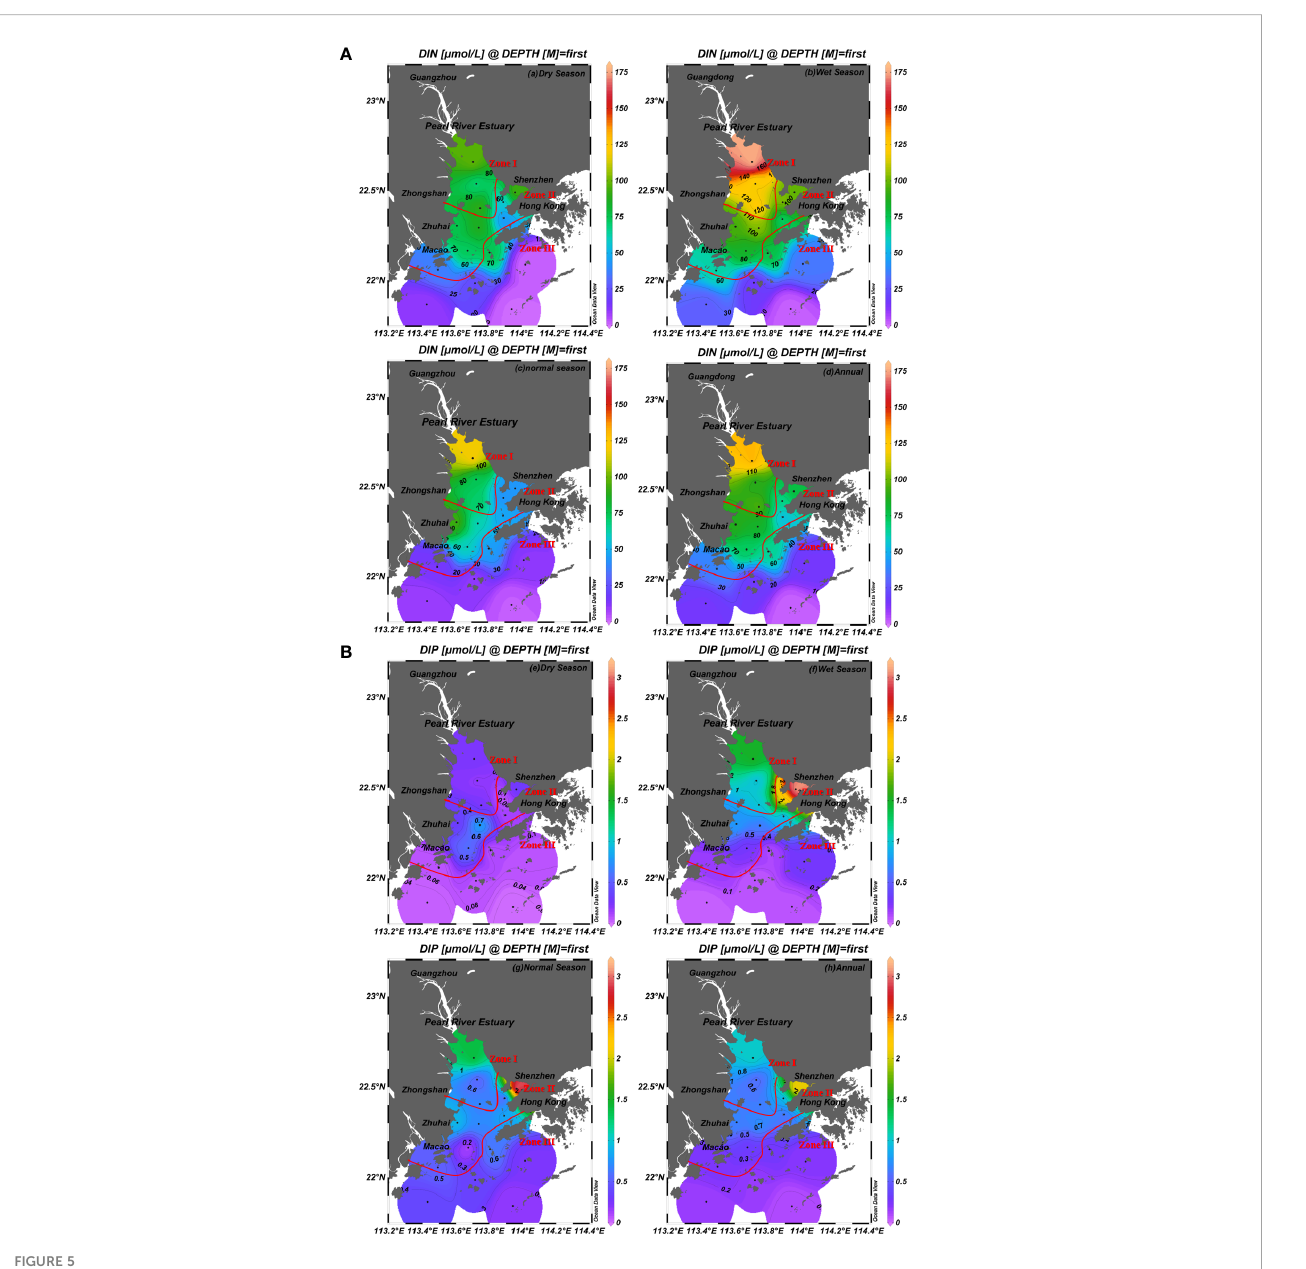
FIGURE 5 Spatiotemporal pattern of DIN (A) and DIP (B) in the PRE.Spatiotemporal variation in TN/TP in the